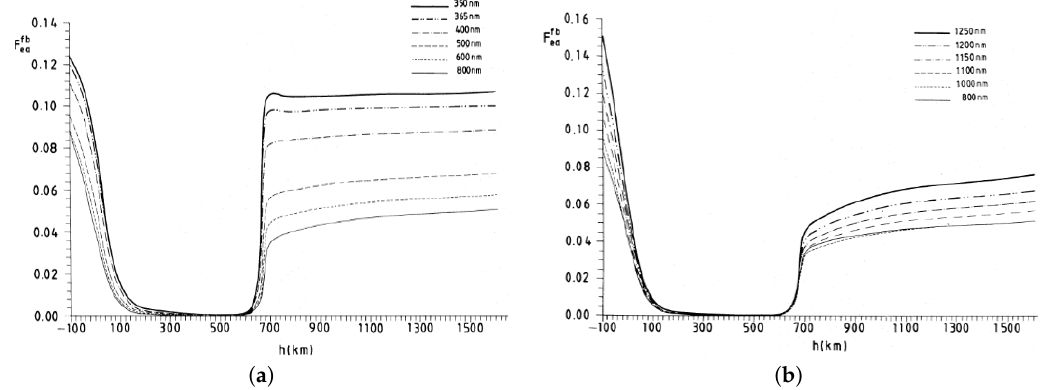
Figure 14. ( a ) the behaviour of the parameter F fb ea ( λ ) as a functions of height h in the solar atmosphere for 350nm ≤ λ ≤ 800nm; ( b ) the behaviour of the parameter F fb ea ( λ ) as a function of height h of the solar atmosphere for 800nm ≤ λ ≤ 1250nm (from